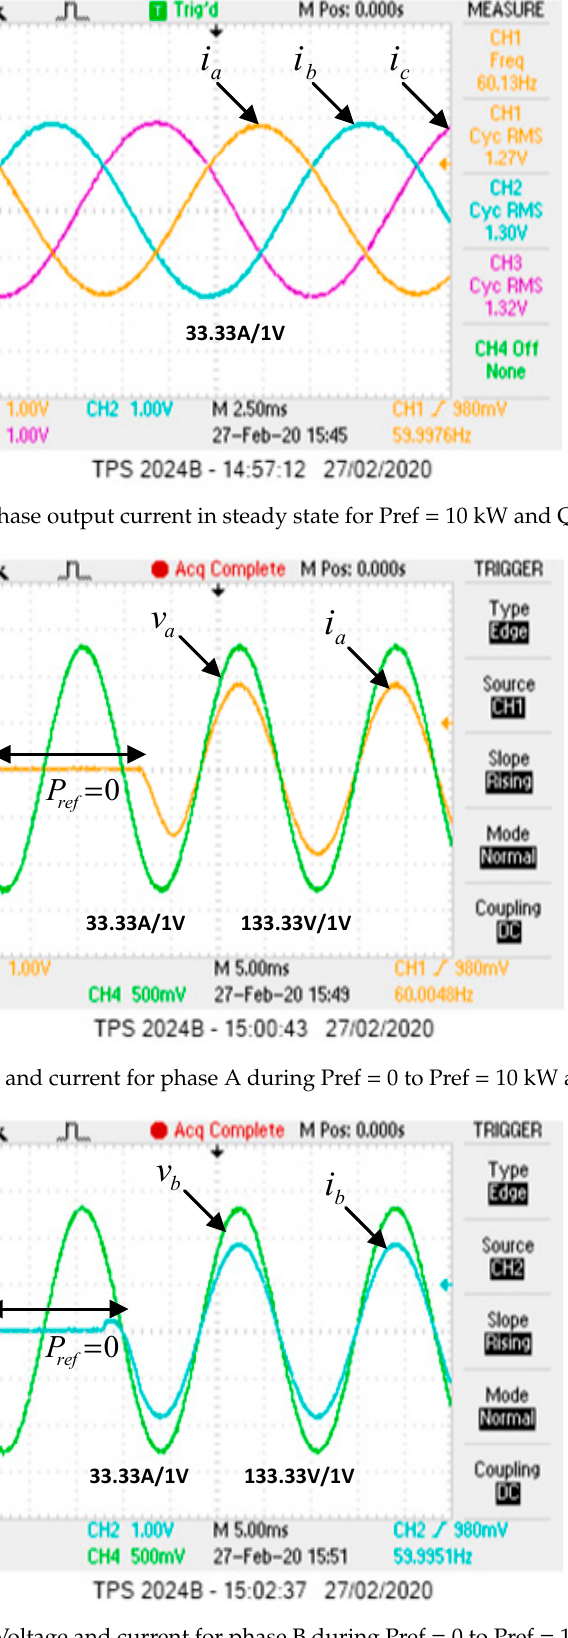
Figure 9. Voltage and current for phase B during Pref = 0 to Pref = 10